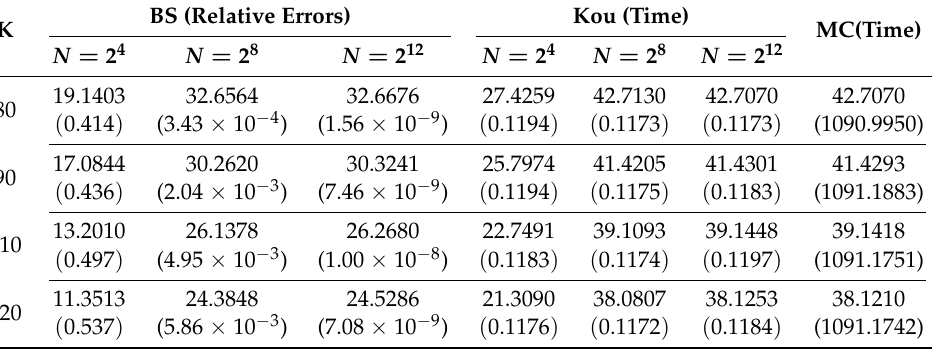
Table 5. Approximation results for finite GMDB, where X is BS or Kou, b ( s ) = ( s − K ) + , T =